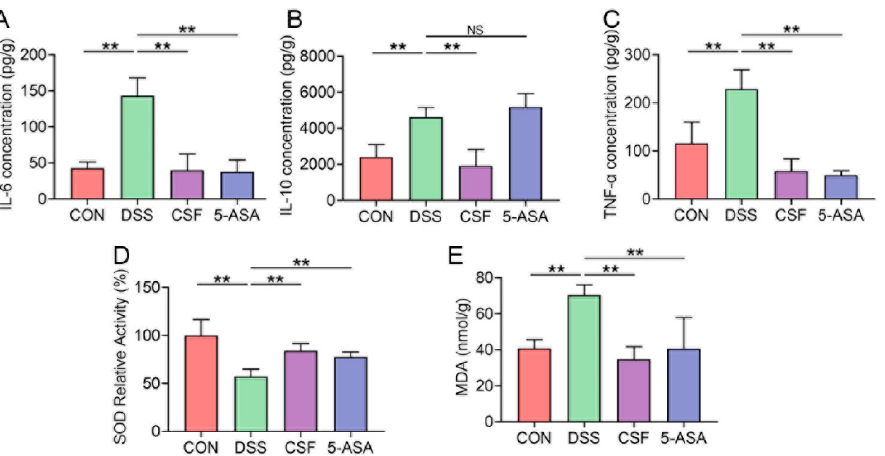
Figure 3. CSF relieved the colonic inflammatory cytokine secretion and oxidative stress in the colitis mice ( n = 8). ( A – C ) The enzyme-linked immunosorbent assay (ELISA) results for interleukin- 6 (IL- 6), IL-10, tumour necrosis factor- α (TNF- α ) of the mice in each group. ( D – E ) The superoxide dis- mutase (SOD) and malondialdehyde (MDA) assays results of the mice in each group. The data are presented as mean ± SD, ** p < 0.01, NS: no